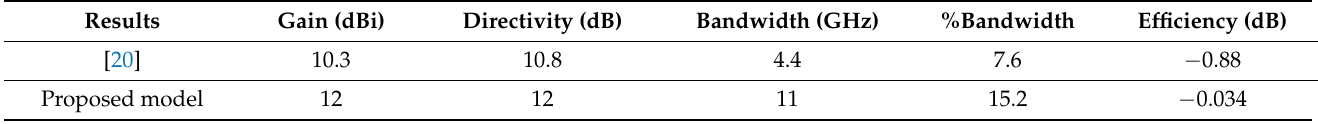
Table 2. Results comparison of current and previous design.